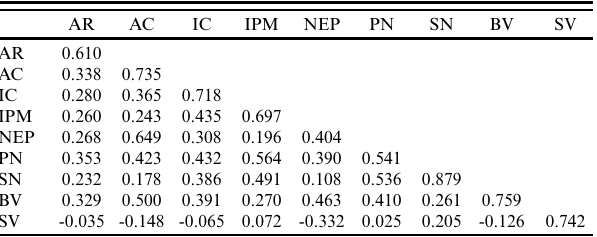
Table 4 . Discriminant validity of the theoretical construct